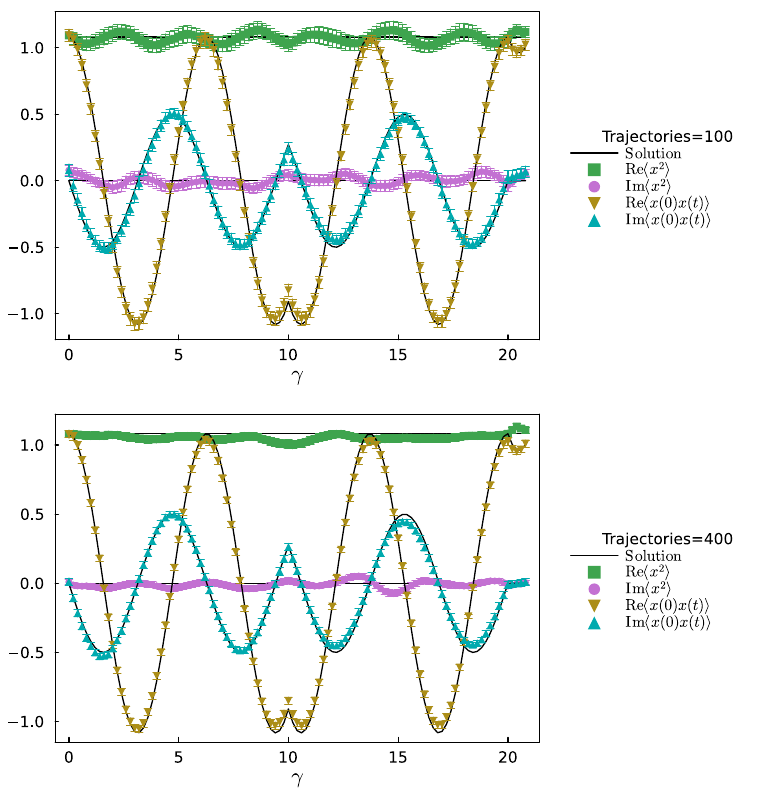
Figure 5 . Harmonic oscillator in the presence of our learned optimal kernel, based on the heuristic gradient from the loss function in eq. (4.6). We simulate on the SK contour with mt = 10 in max real-time and choose m = 1 . Simulating up to mτ = 100 in Langevin time, we combine samples L from 100 (top) and 400 (bottom) different trajectories. Note that improved statistics diminishes the residual oscillatory artifacts in h x 2 i . Values of the correlators from the solution of the Schrödinger equation are given as solid black